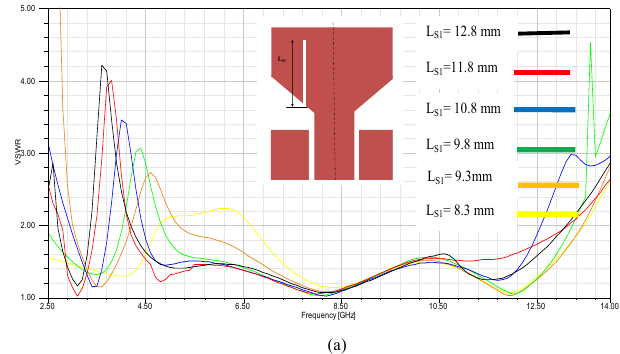
Figure 8: Comparison between the antenna having double slots L S2 and L S3 and the antenna having only a single slot L S2 .